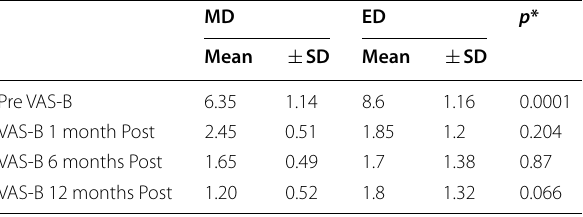
Table 3 Comparison between the 2 study groups regarding the preoperative and the postoperative VAS-B values